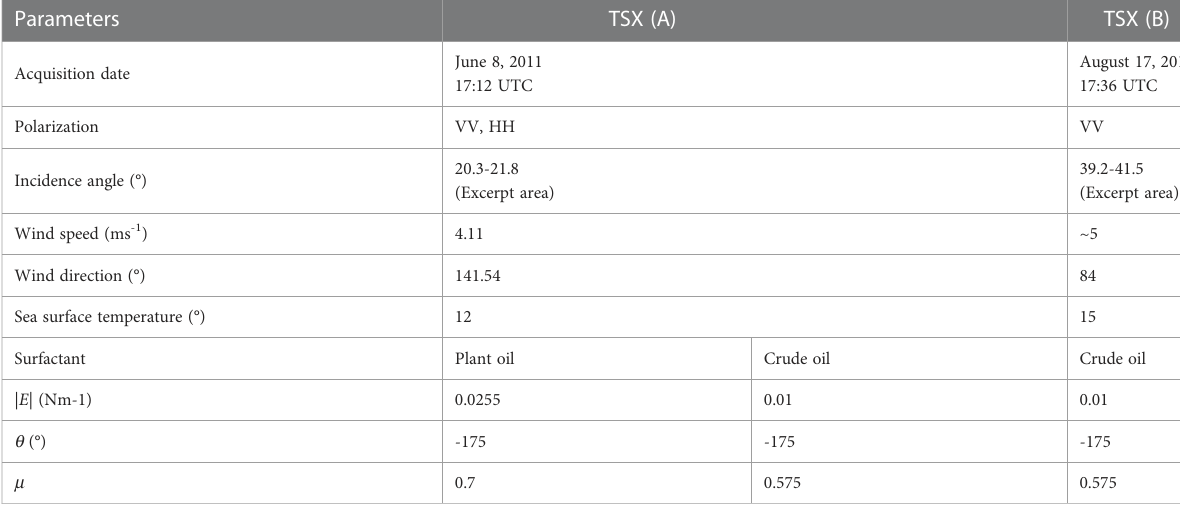
TABLE 1 SAR, Environmental and Rheological